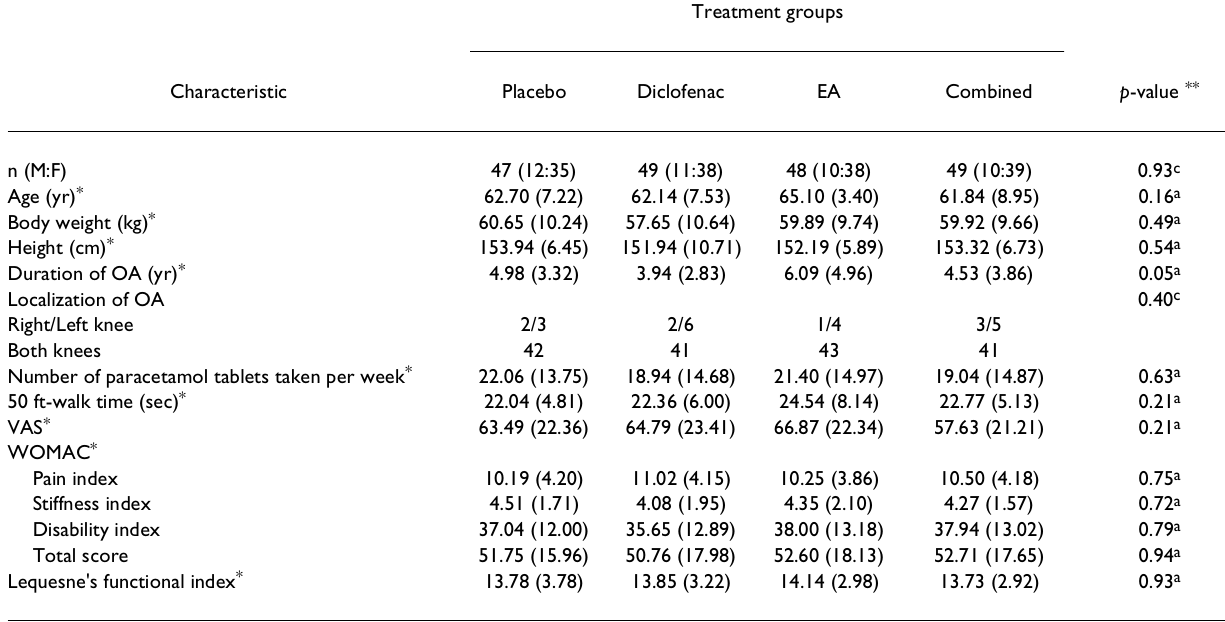
Table 2: Base-line characteristics of patients evaluated at the end of the run-in